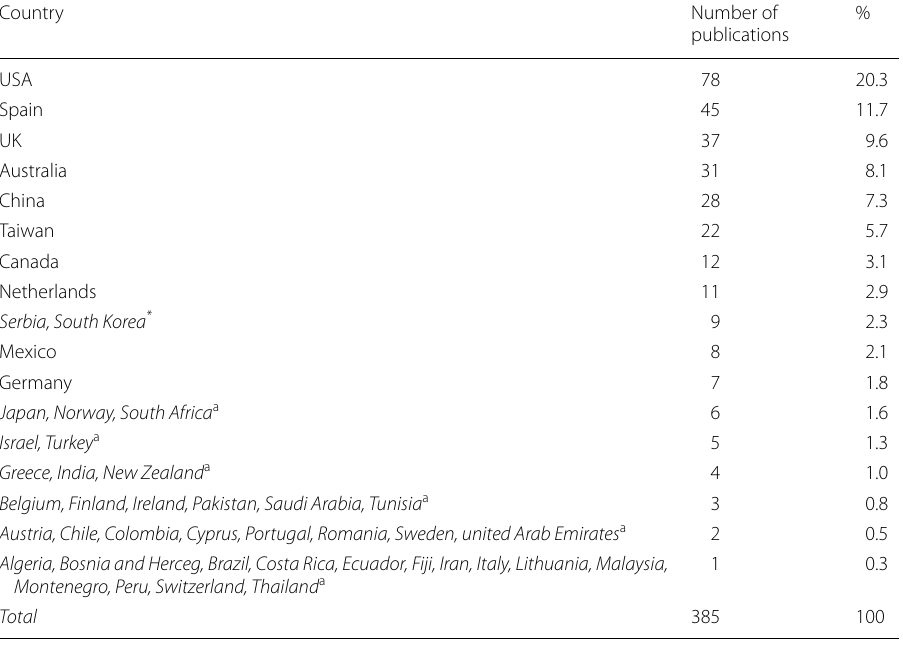
Table 1 Publications per country of affiliation of the first author in SciELO and WoScc databases